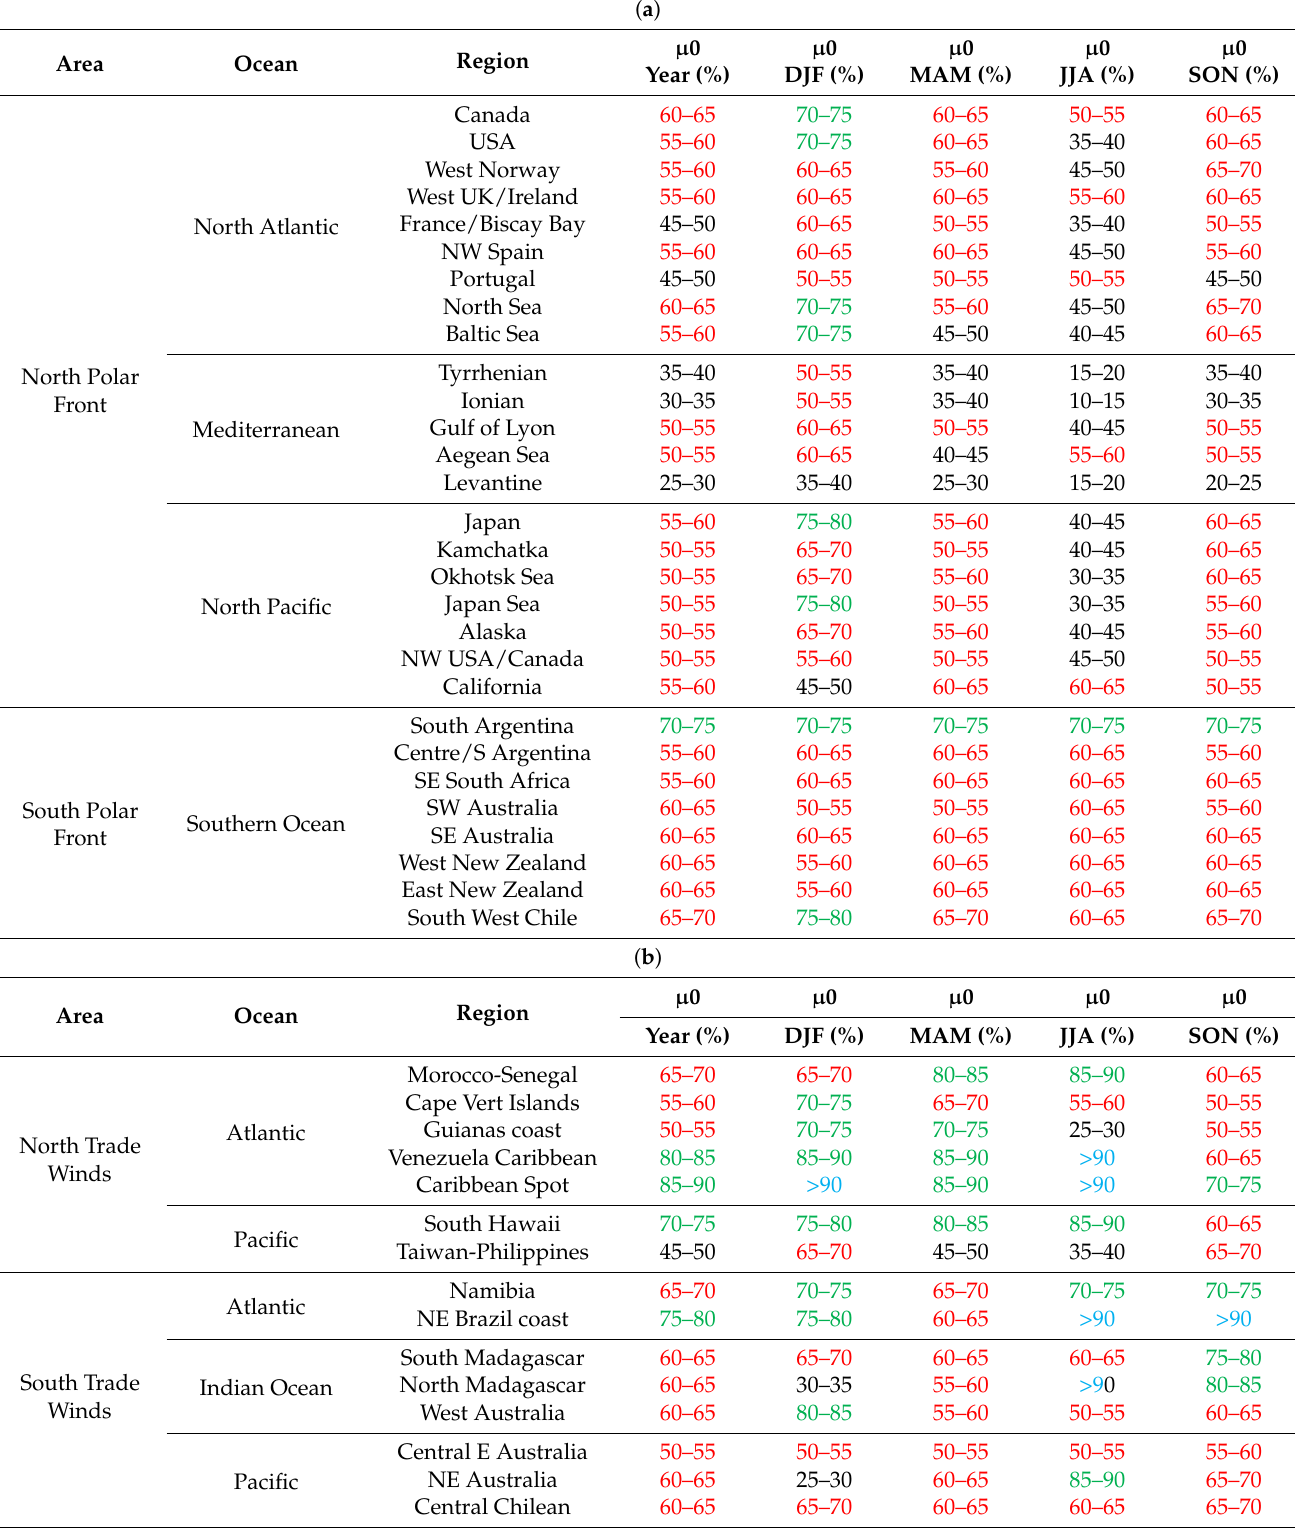
Table 1. ( a ) Ranges of maximum mean operability for the year and for the DJF, MAM, JJA and SON seasons in the polar front coastal regions. Color scale: Good (50–70%), very good (70–90%), excellent ( > 90%). (b ) Ranges of maximum mean operability for the year and for the DJF, MAM, JJA and SON seasons in the trade winds and monsoon coastal regions.